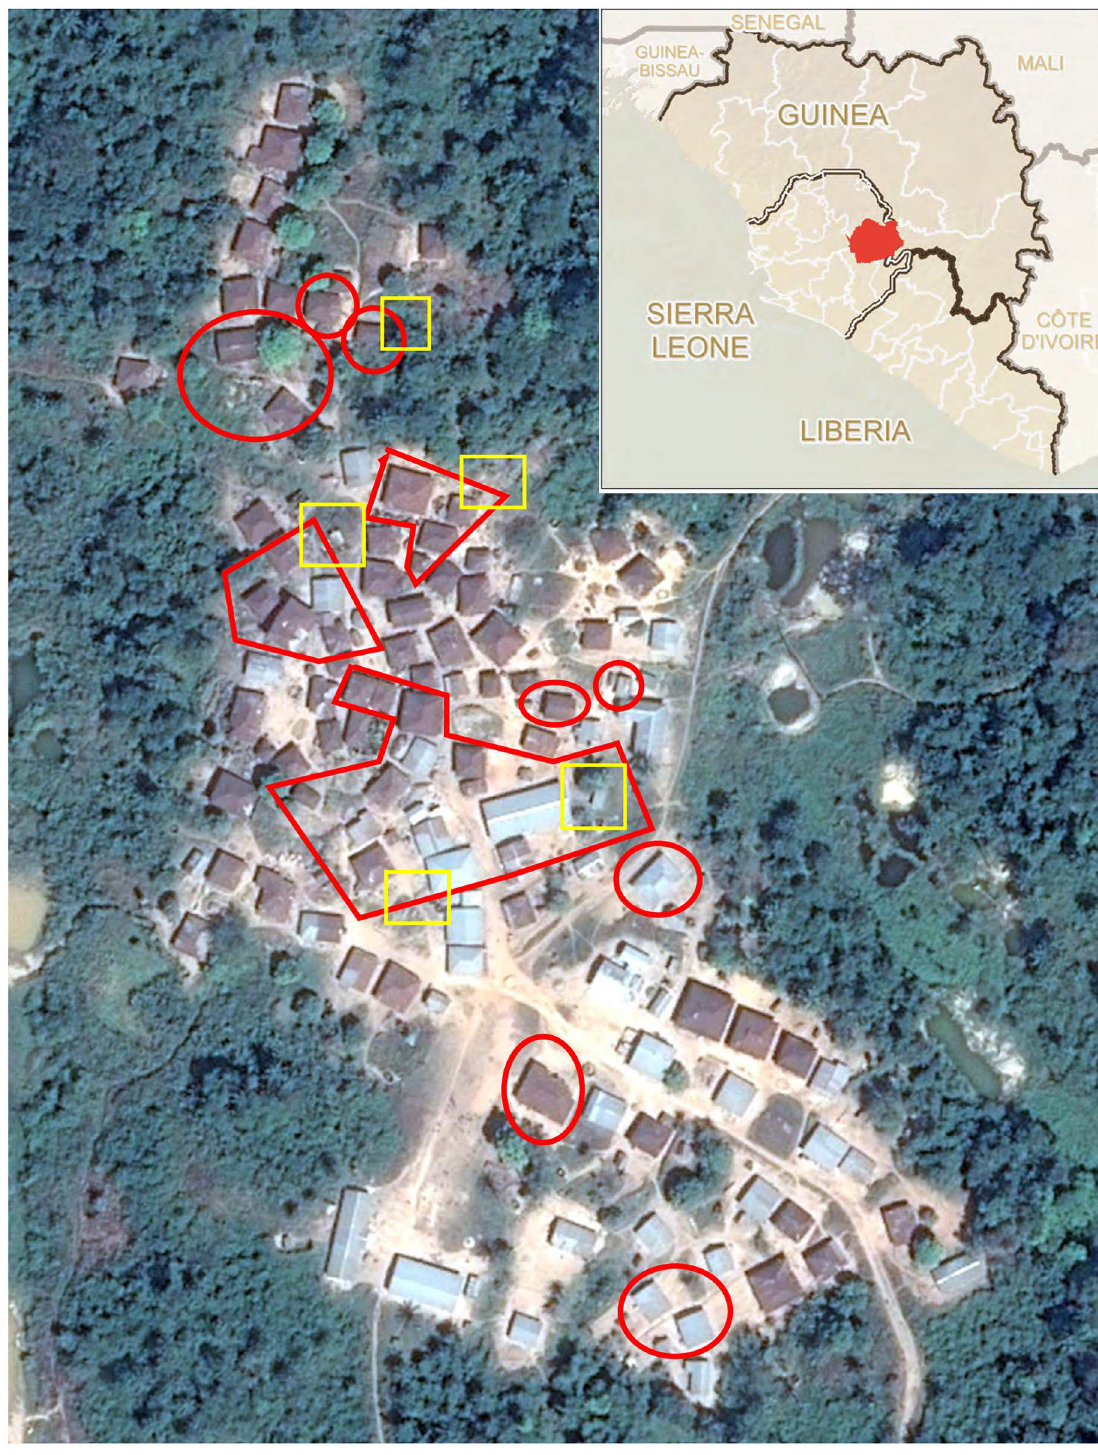
Fig 2. Satellite image of village. Quarantined areas are boundedin red; public latrines in yellow. Source: Google Earth Pro. (Inset: Sierra Leone and surrounds. Kono District in red. Source: Centers for Disease Control and Prevention.)